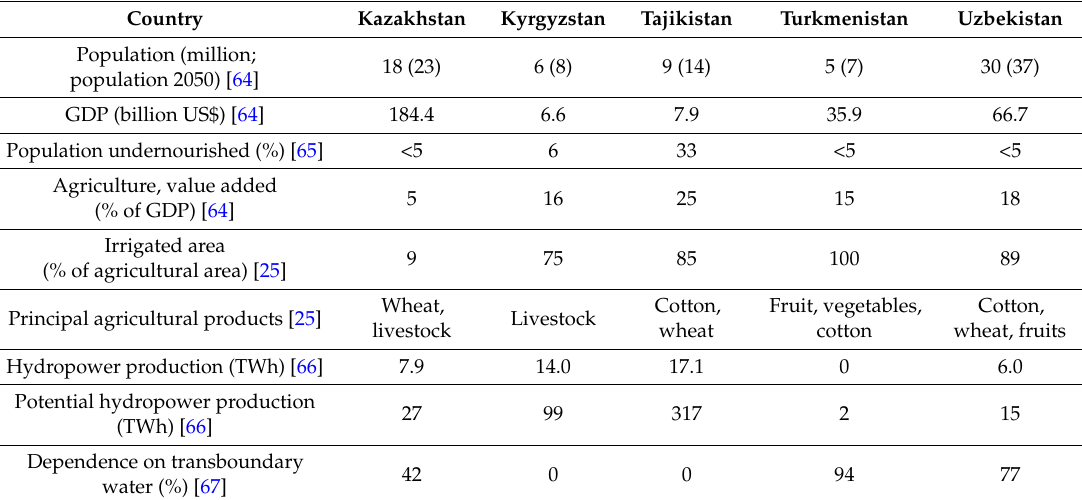
Table 2. Central Asia socioeconomic